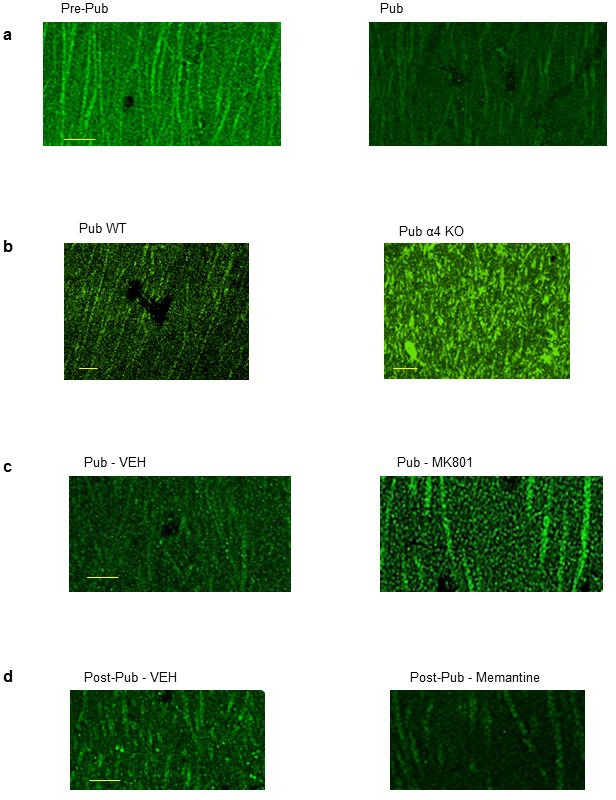
Kalirin-7 expression varies across pubertal stage, α4 genotype and level of pubertal NMDAR expression.Representative images of Kalirin-7 (Kal7) expression in CA1 hippocampus across pubertal stage (a), in pubertal WT and α4 KO hippocampus (b), following pubertal treatment with vehicle or MK-801 to increase NR1 expression (Aoki et al., 2012) (c) or following post-pubertal treatment with vehicle or memantine to block NMDARs (d). Scale, 10 μm. (Averaged data of pixel intensity included in Figure 3).